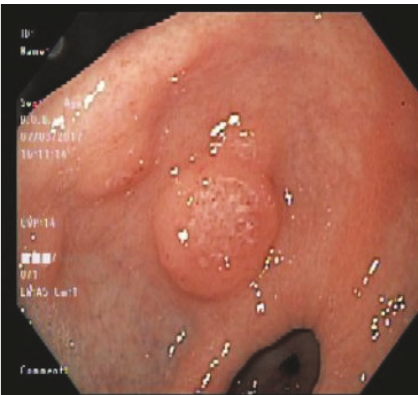
Figure 3: Ulcerated nodule in the gastric body.